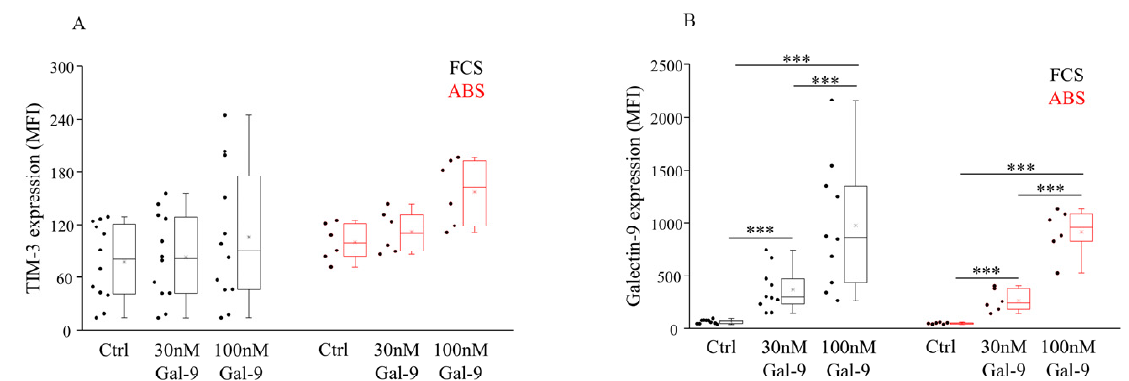
Figure 1. Surface receptor expression by NK-92MI cell line cultured in medium supplemented with FCS or human ABS and after recombinant Gal-9 treatment. The expression of TIM-3 ( A ) and Gal-9 ( B ) by NK-92MI cells following 30 and 100 nM Gal-9 addition, cultured in medium supplemented with 10% FCS or 10% human ABS. The solid bars represent medians of 10 determinations, the boxes indicate the interquartile ranges, and the lines show the most extreme observations. Differences were considered statistically significant for p -values *** < 0.01.